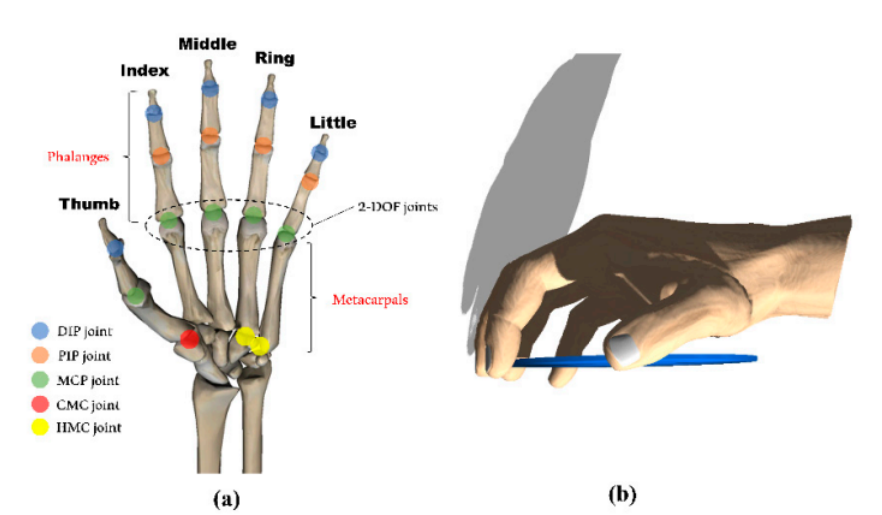
Figure 1. ( a ) A skeletal joint model of the human hand; ( b ) the grasp type used: precision disk